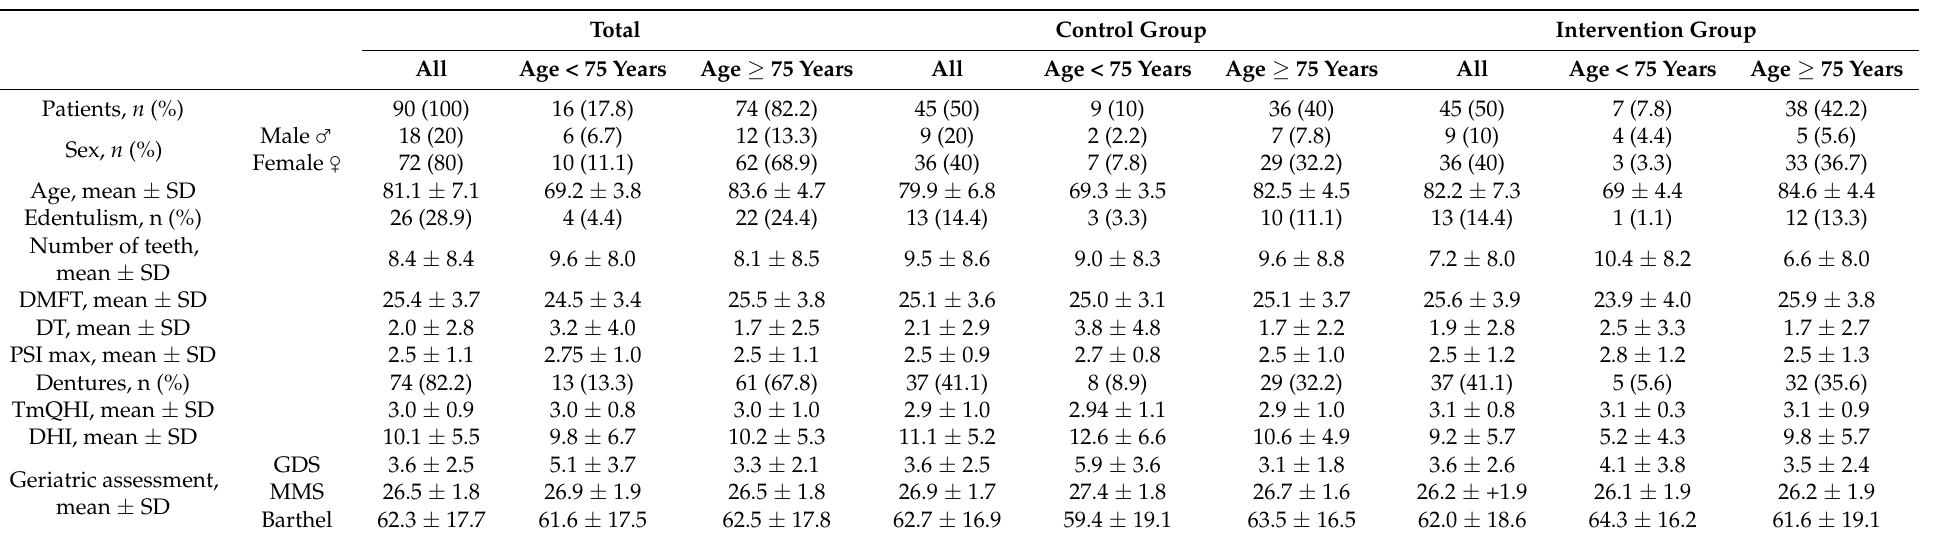
Table 1. Study population’s age, sex, oral status, and geriatric assessment at baseline